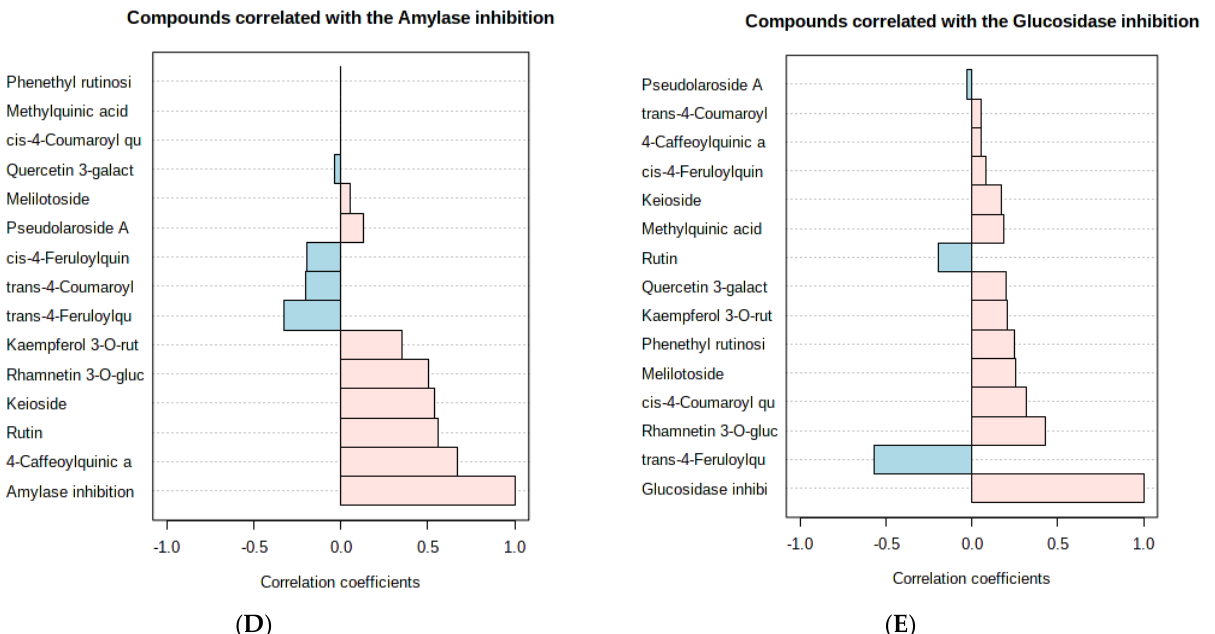
Figure 2. ( A – E ) Shows the correlations of metabolites involved in antioxidant activity, FRAP, ABTS, DPPH and inhibition of α -glucosidase and α -amylase.